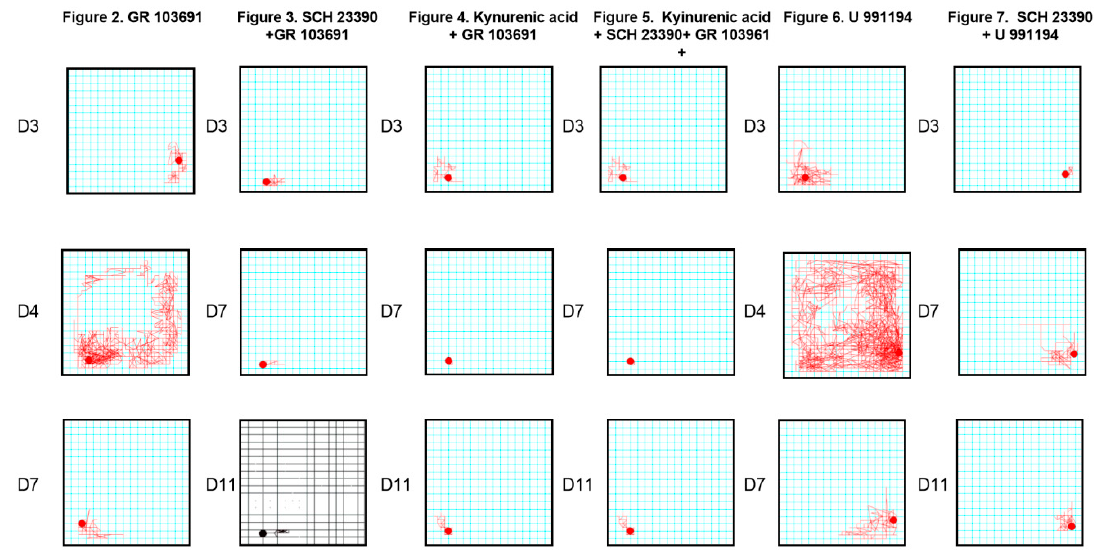
Figure 8. Graphic representation of the locomotor activity records of one rat of each experimental group performed by the automatized software of the locomotor activity box under the different experimental conditions explored in this study. The square represents the field area, and the red lines indicate the runs executed by animals. At the top is the figure that corresponds to the set of experiments, and on the left side of the figure is the corresponding 20 min dialysate.